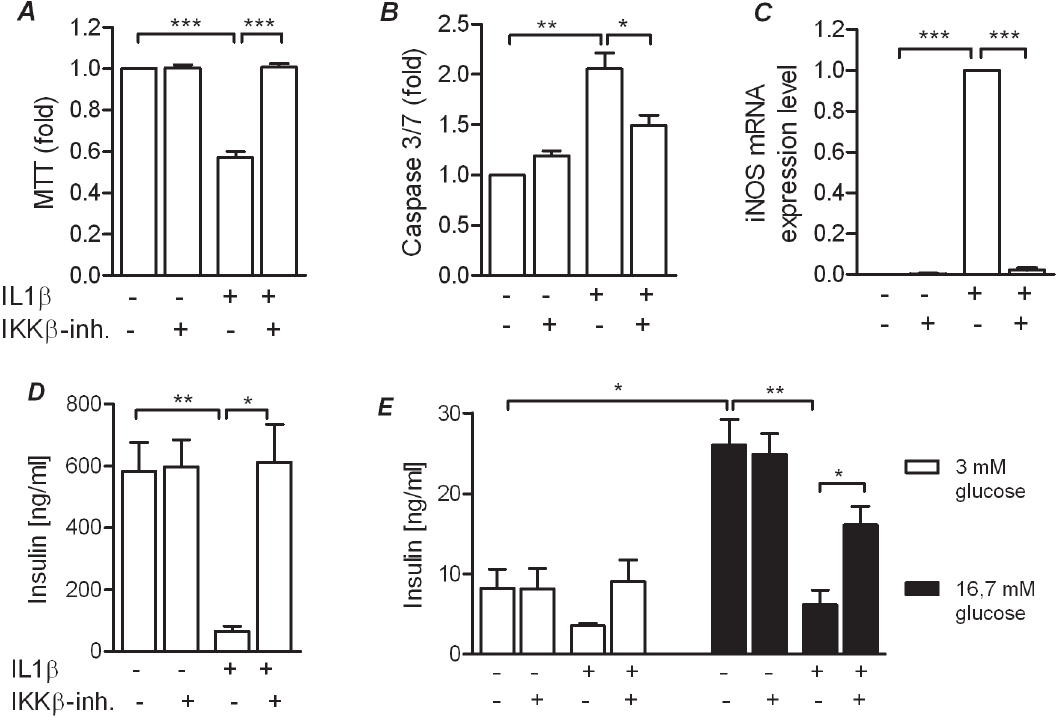
Figure 1. Prevention of IL-1 mediated beta cell toxicity in INS-1 cells by an IKK b -inhibitor. Rat insulinoma (INS-1) cells were incubated in the presence and absence of IL-1 b and the IKK b -inhibitor for 48 hours. A : mitochoiondrial activity, a measurement of viability was determined by the MTT assay (Promega, USA). B : Cell death was measure as caspase 3/7 activity. C : iNOS mRNA expression was quantified using RT-PCR after cells had been incubation for 24 hours in the presence and absence of IL-1 b and the IKK b -inhibitor. D : Accumulated Insulin in the media was measured after 48 hours incubation in the presence or absence of IL-1 b and the IKK b -inhibitor. E : GSIS was performed after 48 hours incubation in the presence or absence of IL-1 b and the IKK b -inhibitor. All data are shown as the mean 6 S.E.M. (*p , 0,05; **p , 0,01; ***p ,